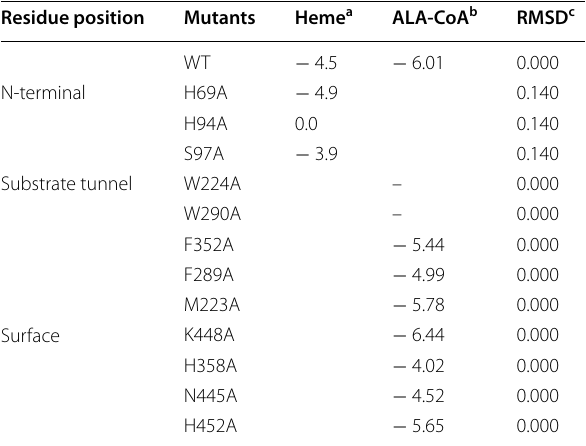
Table 2 Docking scores of Mp FADS6 mutants with